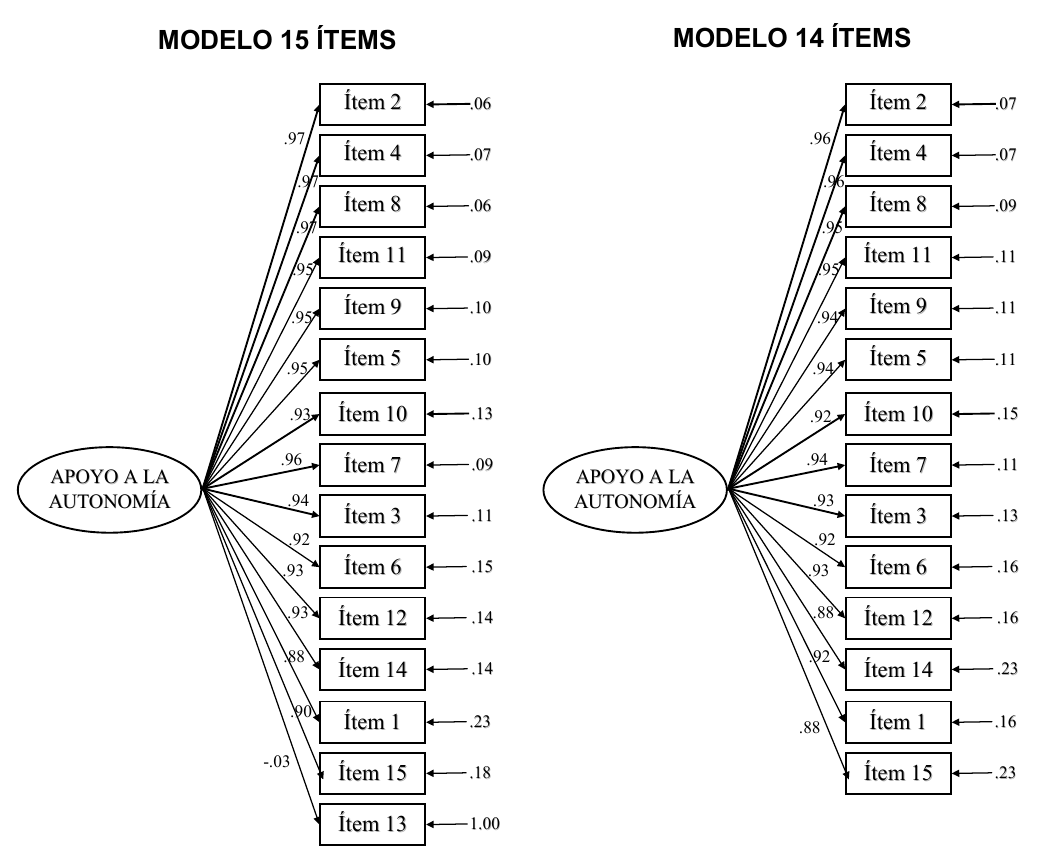
Figura 1. Path diagram del AFC, con pesos estandarizados y errores de medición de cada uno de los ítems del LCQ en alumnado de EF en